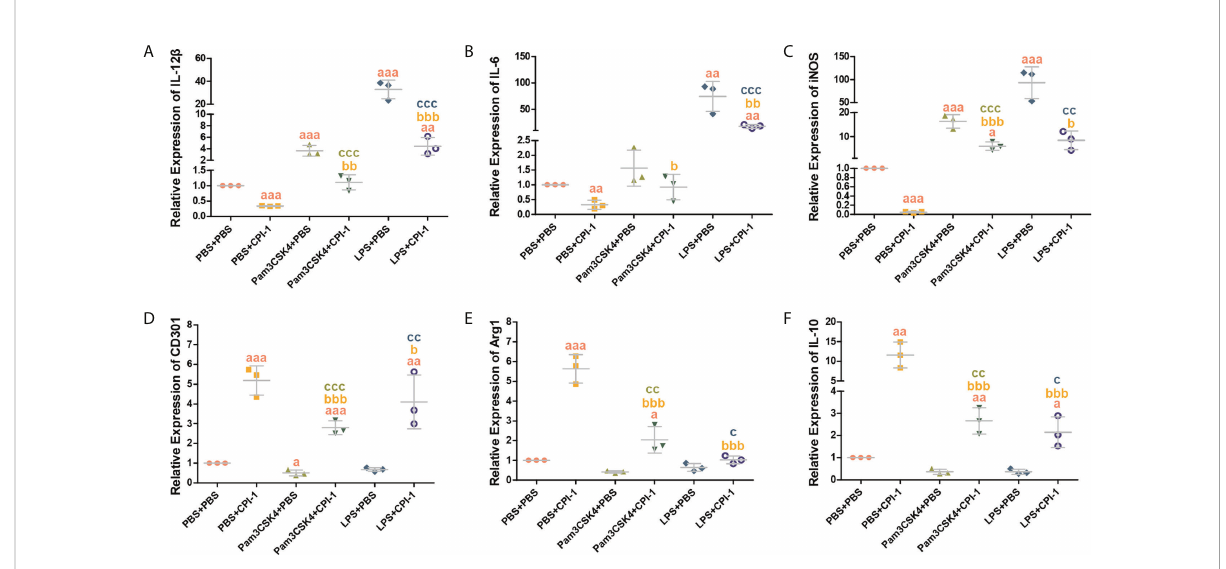
FIGURE 7 Activation experiments were performed to analyze TLR2/4 directly affecting the polarization of MDMs. qPCR analysis of the transcript levels of M1 macrophage surface marker molecules (A – C) and M2 macrophage surface marker molecules (D – F) . The data are shown as the mean ± SD of 3 repetitions per group. a P ≤ 0.05, aa P ≤ 0.01, and aaa P ≤ 0.001 vs. the control group (PBS + PBS); b P ≤ 0.05, bb P ≤ 0.01, and bbb P ≤ 0.001 for the Pam3CSK4 + rBsCPI-1, or LPS + rBsCPI-1 group vs. the PBS + rBsCPI-1 group; c P ≤ 0.05, cc P ≤ 0.01, and ccc P ≤ 0.001 for the Pam3CSK4 +